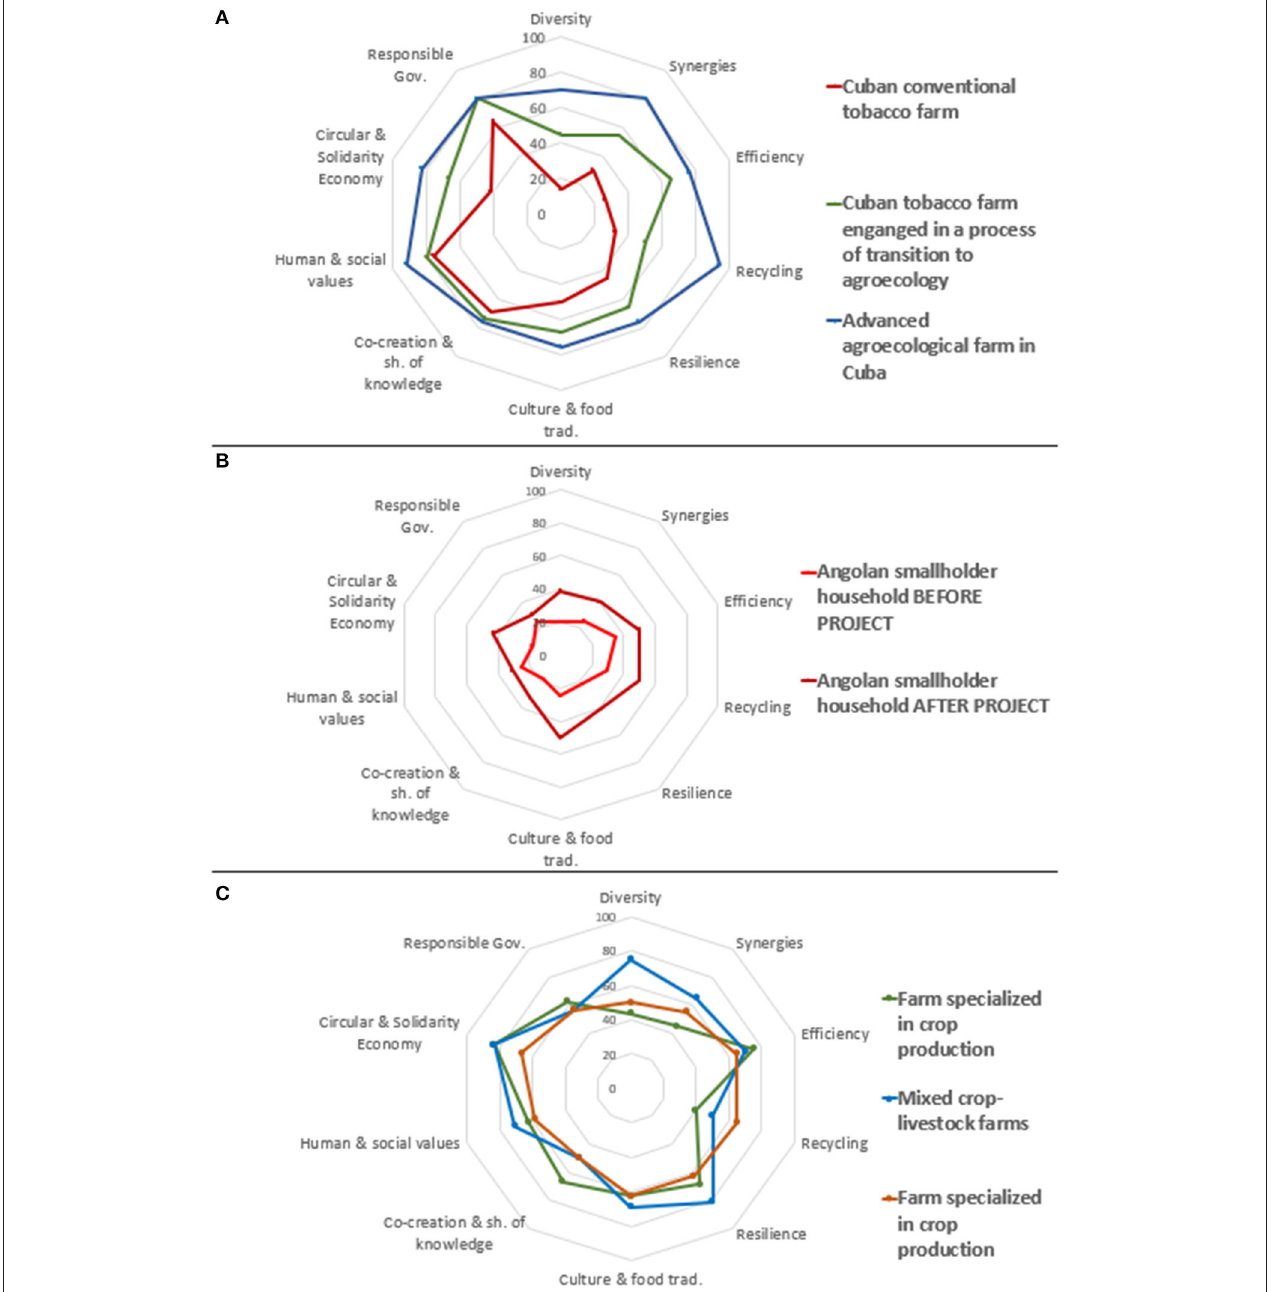
FIGURE 3 | Results of the CAET (Step 1) from (A) a family farm in western Cuba at different stages transitioning to agroecology (Lucantoni, 2020); (B) a smallholder farm of Central Angola, before and after a project for sustainable rural development and improved nutrition and (C) 25 farms in Patagonia (Argentina) after using the Step 1-bis Transition Typology (Álvarez et al.,